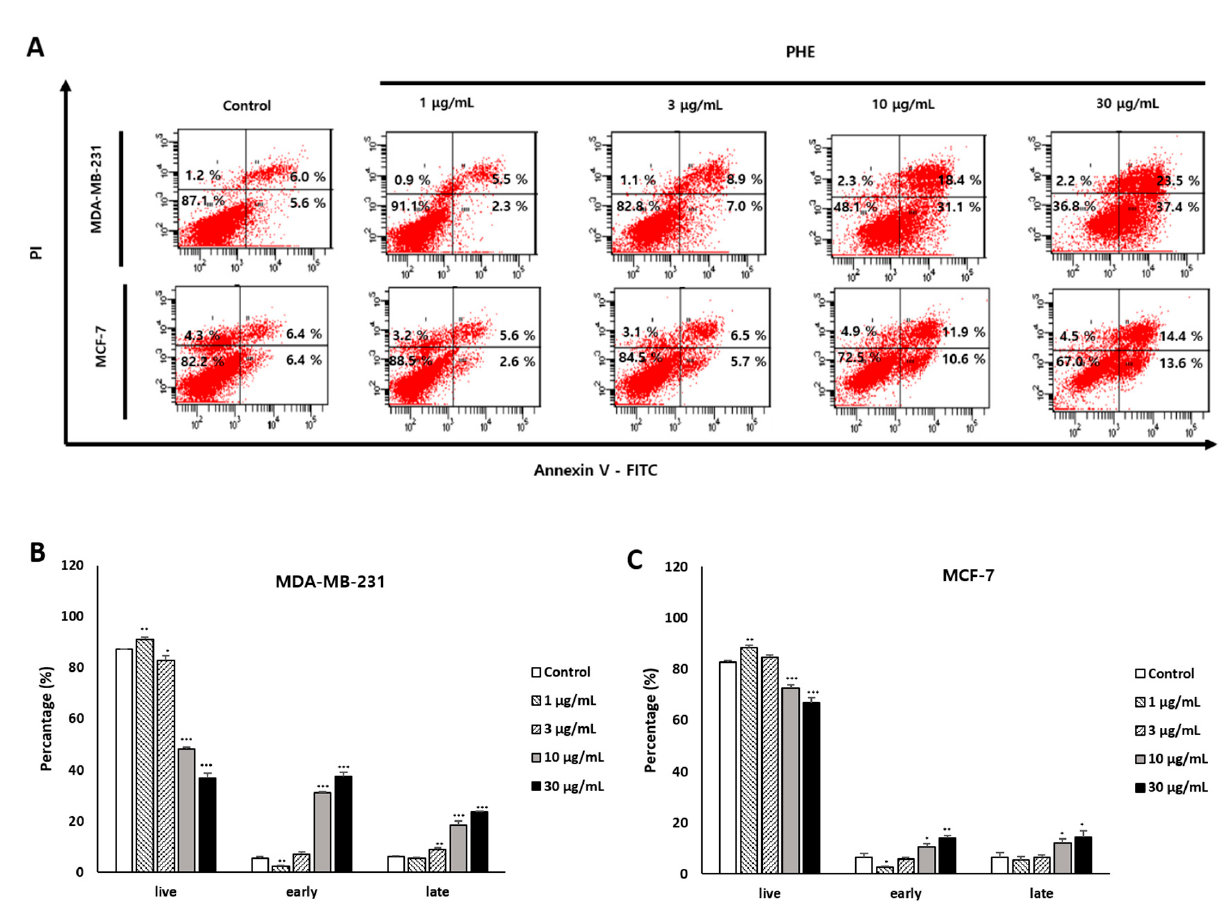
Figure 3. A 48-h treatment of Physconia hokkaidensis methanol extract (PHE) induces MDA-MB-231 cell membrane change. ( A ) Cells were treated with PHE for 48 h and stained with annexin V/PI. ( B , C ) Statistical analysis of the apoptosis ratio of MDA-MB-231 and MCF-7 cells after PHE treatment. All data are expressed as mean ± SD of three independent experiments. * p < 0.05, ** p < 0.01, *** p < 0.001 compared to the control of each cell line.